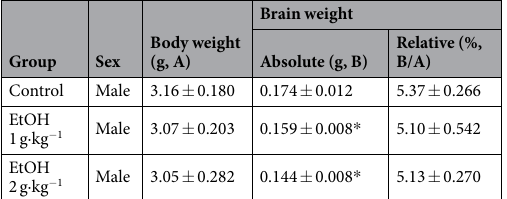
Table 1. Body and brain weights of P3 newborns prenatally exposed to ethanol (EtOH). * P < 0.05, n = 18.